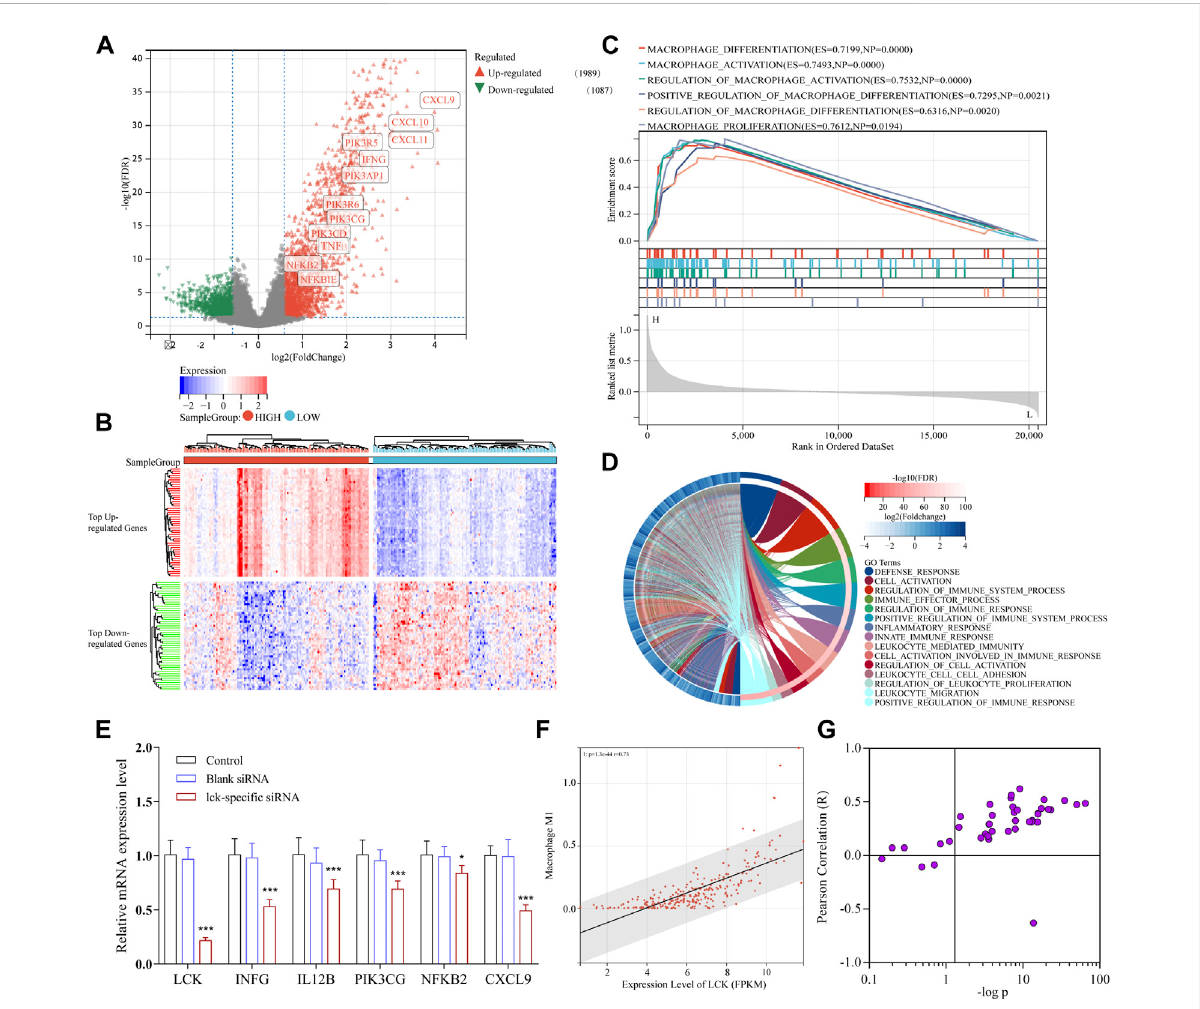
FIGURE 4 Functional analysis of downstream signaling associated with LCK expression in TCGA-SARC cohort. (A) Volcano plot of differentially expressed genes in the gene expression pro fi les between high- and low-LCK groups. There were 1989 upregulated genes and 1,087 downregulated genes among 20,475 genes in expression pro fi les. (B) Heatmap of top 25 upregulated and downregulated genes between high- and low-LCK groups. (C) GSEA analysis of the GO biological process. (D) GO biological process enrichment analysis of differentially expressed genes between LCK-low and-highgroups. (E) PCRresultsofkeygenesintheLCK-involvedregulatoryaxisofTAMin fi ltrationinA-673cellstransfectedwithandwithoutLCK- speci fi csiRNAs.ThecorrelationbetweentheexpressionlevelofLCKandlevelofM1-likemacrophagein fi ltrationinSTS (F) andother44typesofsolid tumors (G)